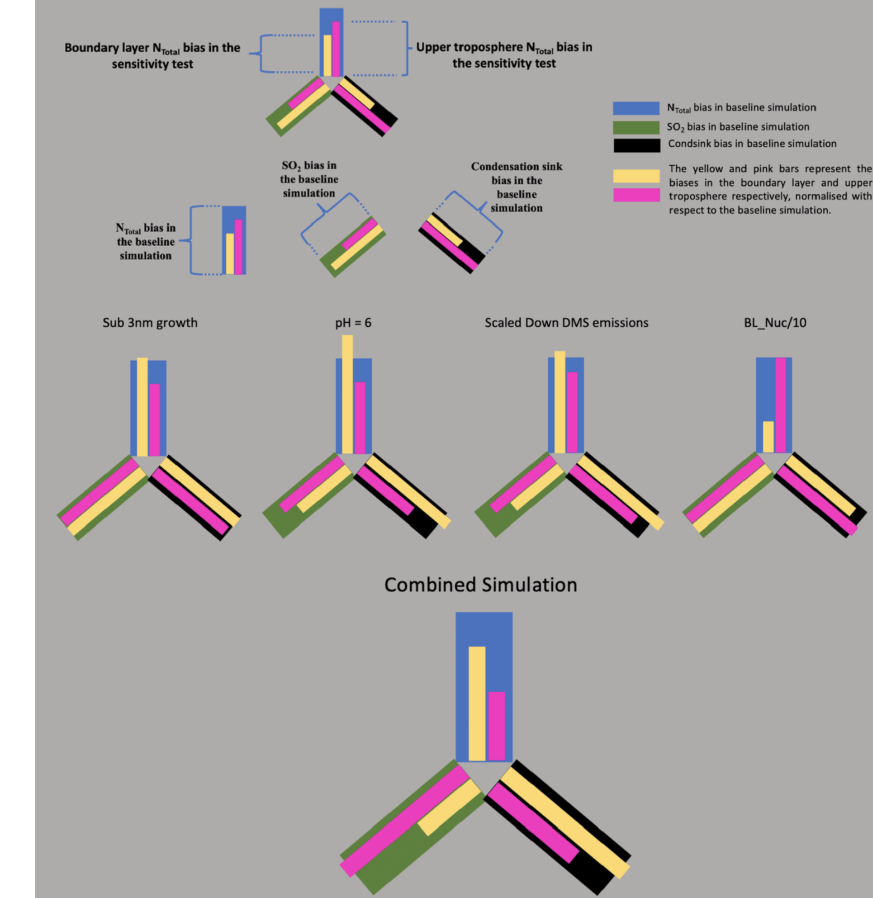
Figure 8. Diagram to represent the N Total , SO 2 and condensation sink biases (in the boundary layer and upper troposphere) for the one-at-a- time sensitivity tests: sub-3nm growth, cloud pH = 6, scaling down DMS emissions, and boundary layer nucleation/10. The blue, green and black legs of the diagram represent the N Total , SO 2 and condensation sink bias respectively. The yellow and pink bars represent the biases in the boundary layer and upper troposphere normalised with respect to the baseline